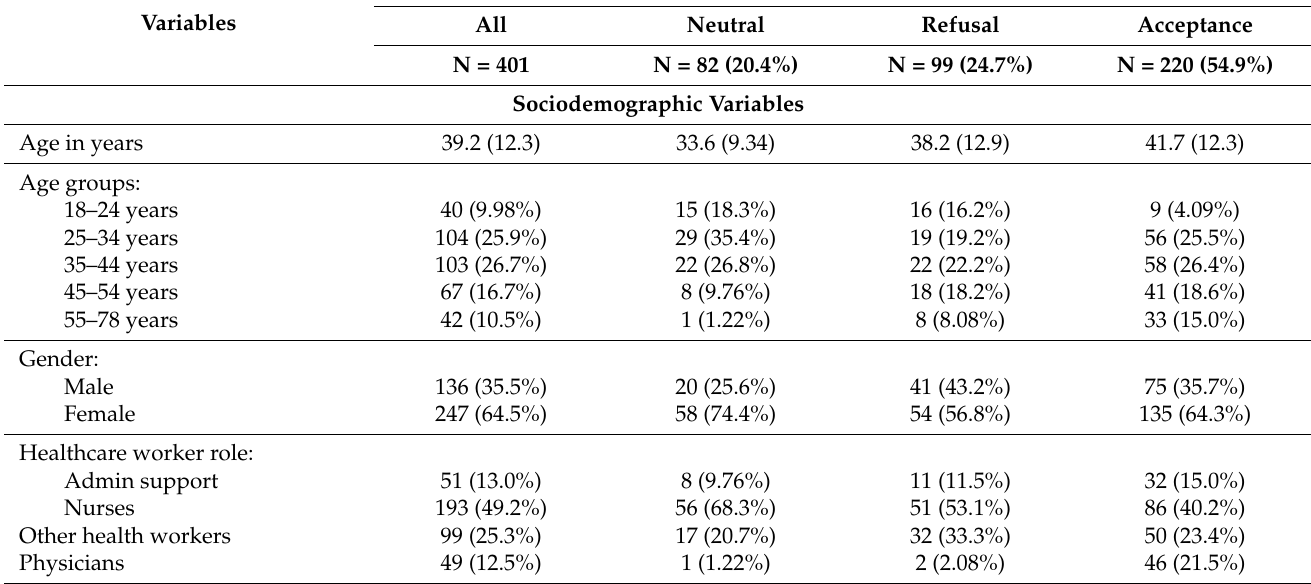
Table 1. Sociodemographic features of 401 healthcare professionals in Cape Town, South Africa, stratified by their intention to accept, decline, or remain neutral once the influenza vaccination is available to them during COVID-19 pandemic. Survey period coincides with the start of COVID-19 vaccine